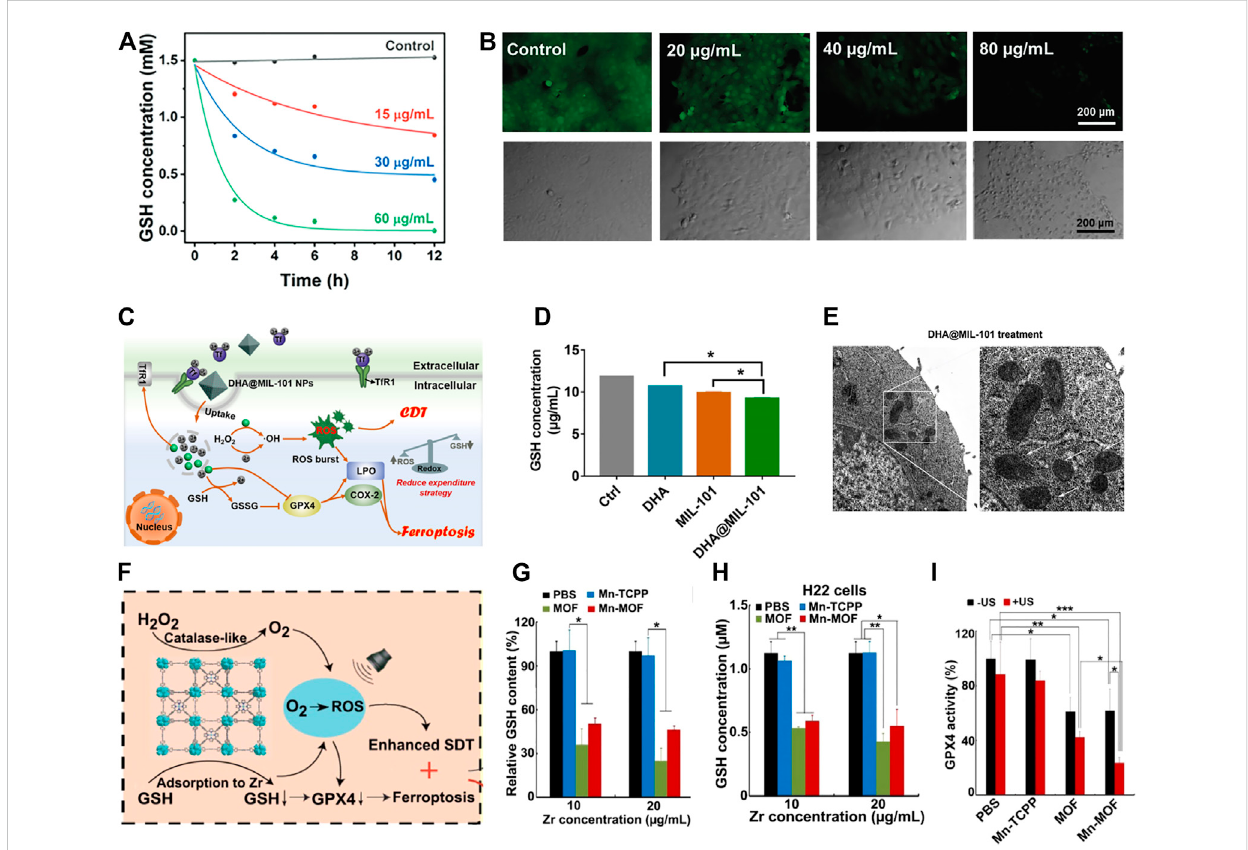
FIGURE 5 (A) Investigation of the capacity of CCF with different concentrations to exhaust GSH at different time points. (B) Variations of GSH fl uorescence intensityand4T1cellssurvivalstatusafterco-cultureofCCFand4T1cellsindifferentconcentrations.Reproducedwithpermission.Copyright2021John Wiley & Sons. (C) The schematic illustration of DHA@MIL-101 NRs prompting CDT-ferroptotic cancer therapy through inactivating GPX4 directly or indirectly. (D) Comparison of GSH content in Lewis cells after incubation with DHA, MIL-101 NRs, and DHA@MIL-101 NRs. (E) The morphology of mitochondria(maincharacteristicofferroptosis)whentreatedwithDHA@MIL-101NRsusingTEM.Reproducedwithpermission.Copyright2022BioMed Central. (F) Schematic diagram of ferroptosis generated by GSH-deletion mediated GPX4 inactivity. (G) Examining GSH depletion capacity of PBS, Mn- TCPP,MOF,andMn-MOFwithdifferentconcentrationsofZr. (H) AlterationsofintracellularGSHcontentand (I) GPX4activityaftertreatmentofH22cells with PBS, Mn-TCPP, MOF, and Mn-MOF respectively. Reproduced with permission. Copyright 2021 Ivyspring International